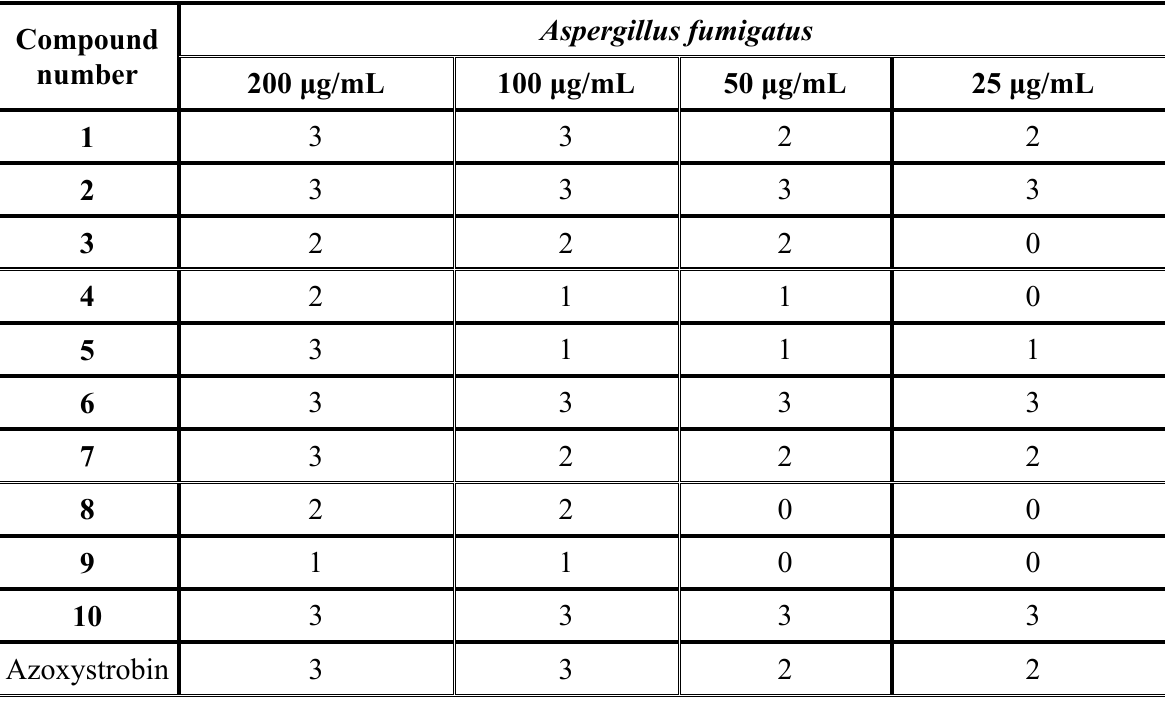
Table 4. The fungicidal activity of the studied compounds against Aspergillus fumigatus .